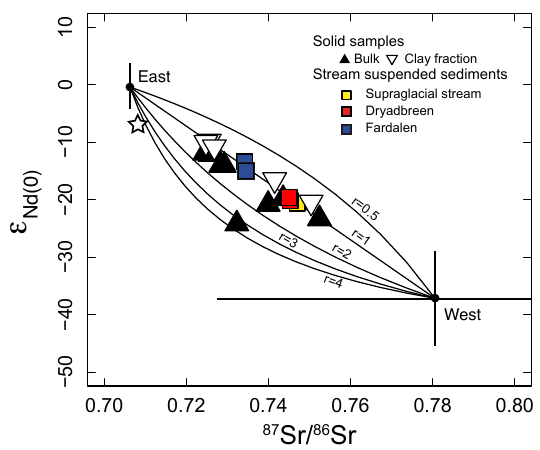
Figure 8. Plot of ε Nd vs. 87 Sr / 86 Sr. The two points “East” ( 87 Sr / 86 Sr = 0.70626, ε Nd =− 0.4) and “West” ( 87 Sr / 86 Sr = 0.78059, ε Nd =− 37.1) are averages of the in- terquartile range of literature data and the error bars indicate the interquartile range (for the “East” source the error in 87 Sr / 86 Sr is too small to see). “East” data ( n = 99): Siberian Traps (Lightfoot et al., 1993; Wooden et al., 1993) and Uralides (Spadea and D’Antonio, 2006). “West” data ( n = 65): Archaean rocks (predom- inantly gneisses, Jacobsen, 1988; Collerson et al., 1989; Kalsbeek and Frei, 2006; Friend et al., 2009), basal ice particles from GISP 2 and GRIP and granite bedrock samples from GISP 2 (Weis et al., 1997). The “ r ” values are the Sr / Nd ratio of the “East” source divided by the Sr / Nd ratio of the “West” source. The star indicates the isotopic composition of Eocene seawater (Gleason et al., 2009, see text for